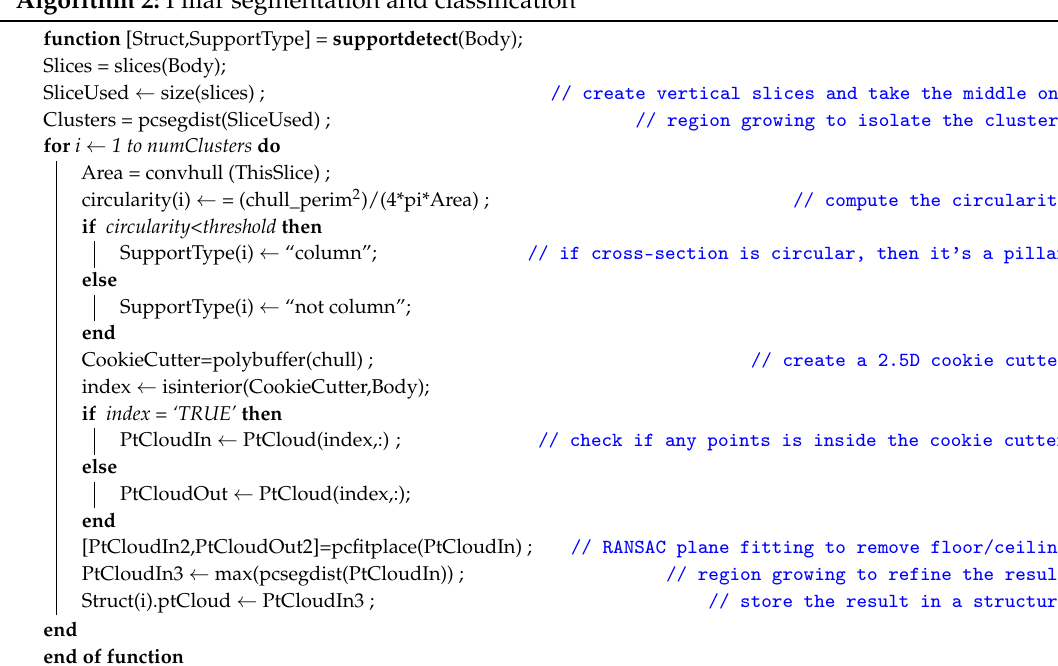
Algorithm 2: Pillar segmentation and